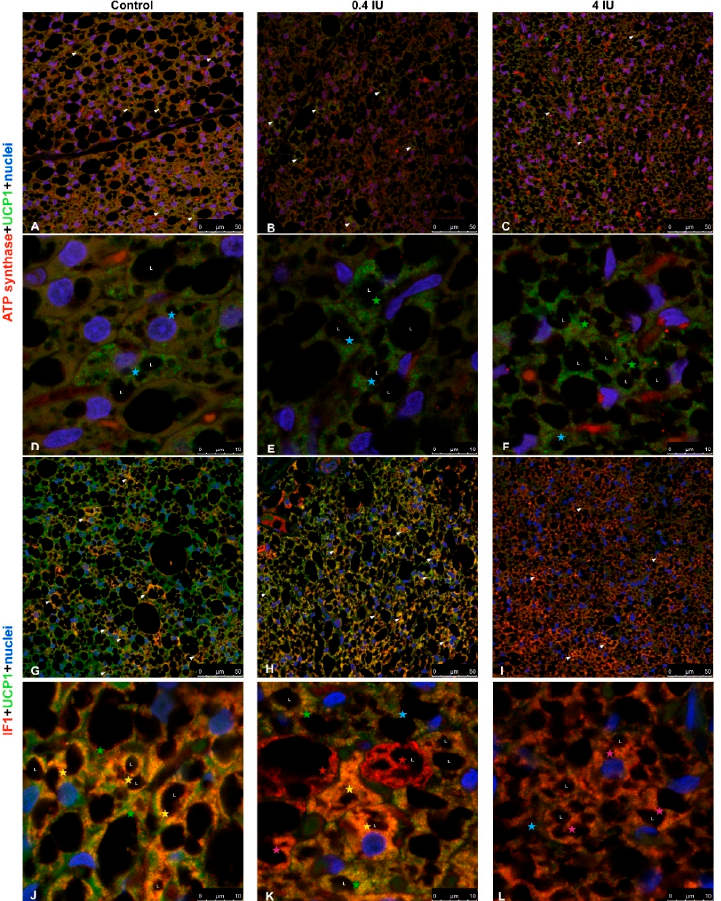
Figure 12. Immunofluorescence of UCP1/ATP synthase and UCP1/IF1 in BAT following chronic insulin treatment. ( A – F ) Double labeling with antibodies against UCP1 (green) and ATP synthase (red). ( G – L ) Double labeling with antibodies against UCP1 (green) and IF1 (red). Harlequin effect is shown with arrowheads. BAT showed various brown adipocytes with different degrees of immunoexpression: UCP1-only brown adipocytes (light-blue star); UCP1 predominantly positive brown adipocytes (green star); brown adipocytes with clear colocalization of UCP1 and ATP synthase / IF1 (yellow star); ATP synthase / IF1 predominantly positive brown adipocytes (pink star); and ATP synthase / IF1-only brown adipocytes (red star). L—lipid body. Nuclei were stained with Sytox Orange. ( A – C , G – I ), scale bar = 50 µ m. ( D – F , J – L ), scale bar = 10 µ